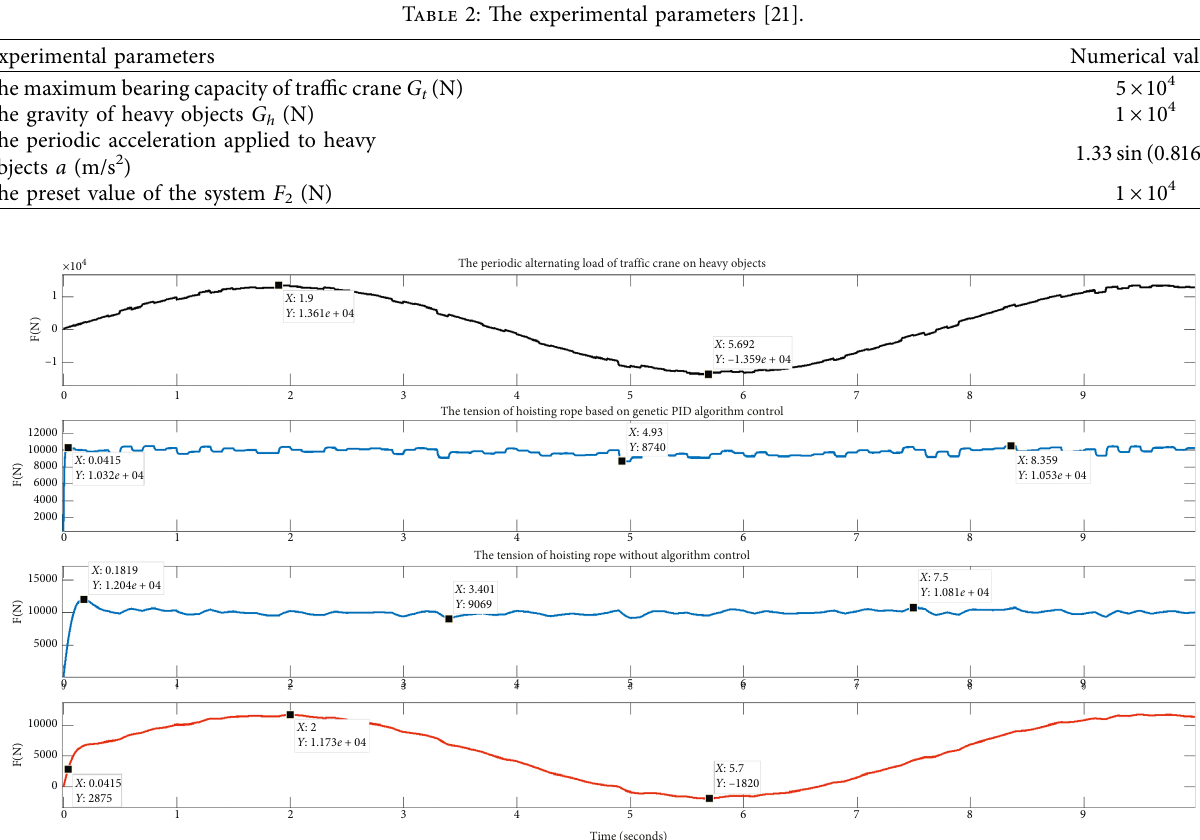
Figure 17: The experimental